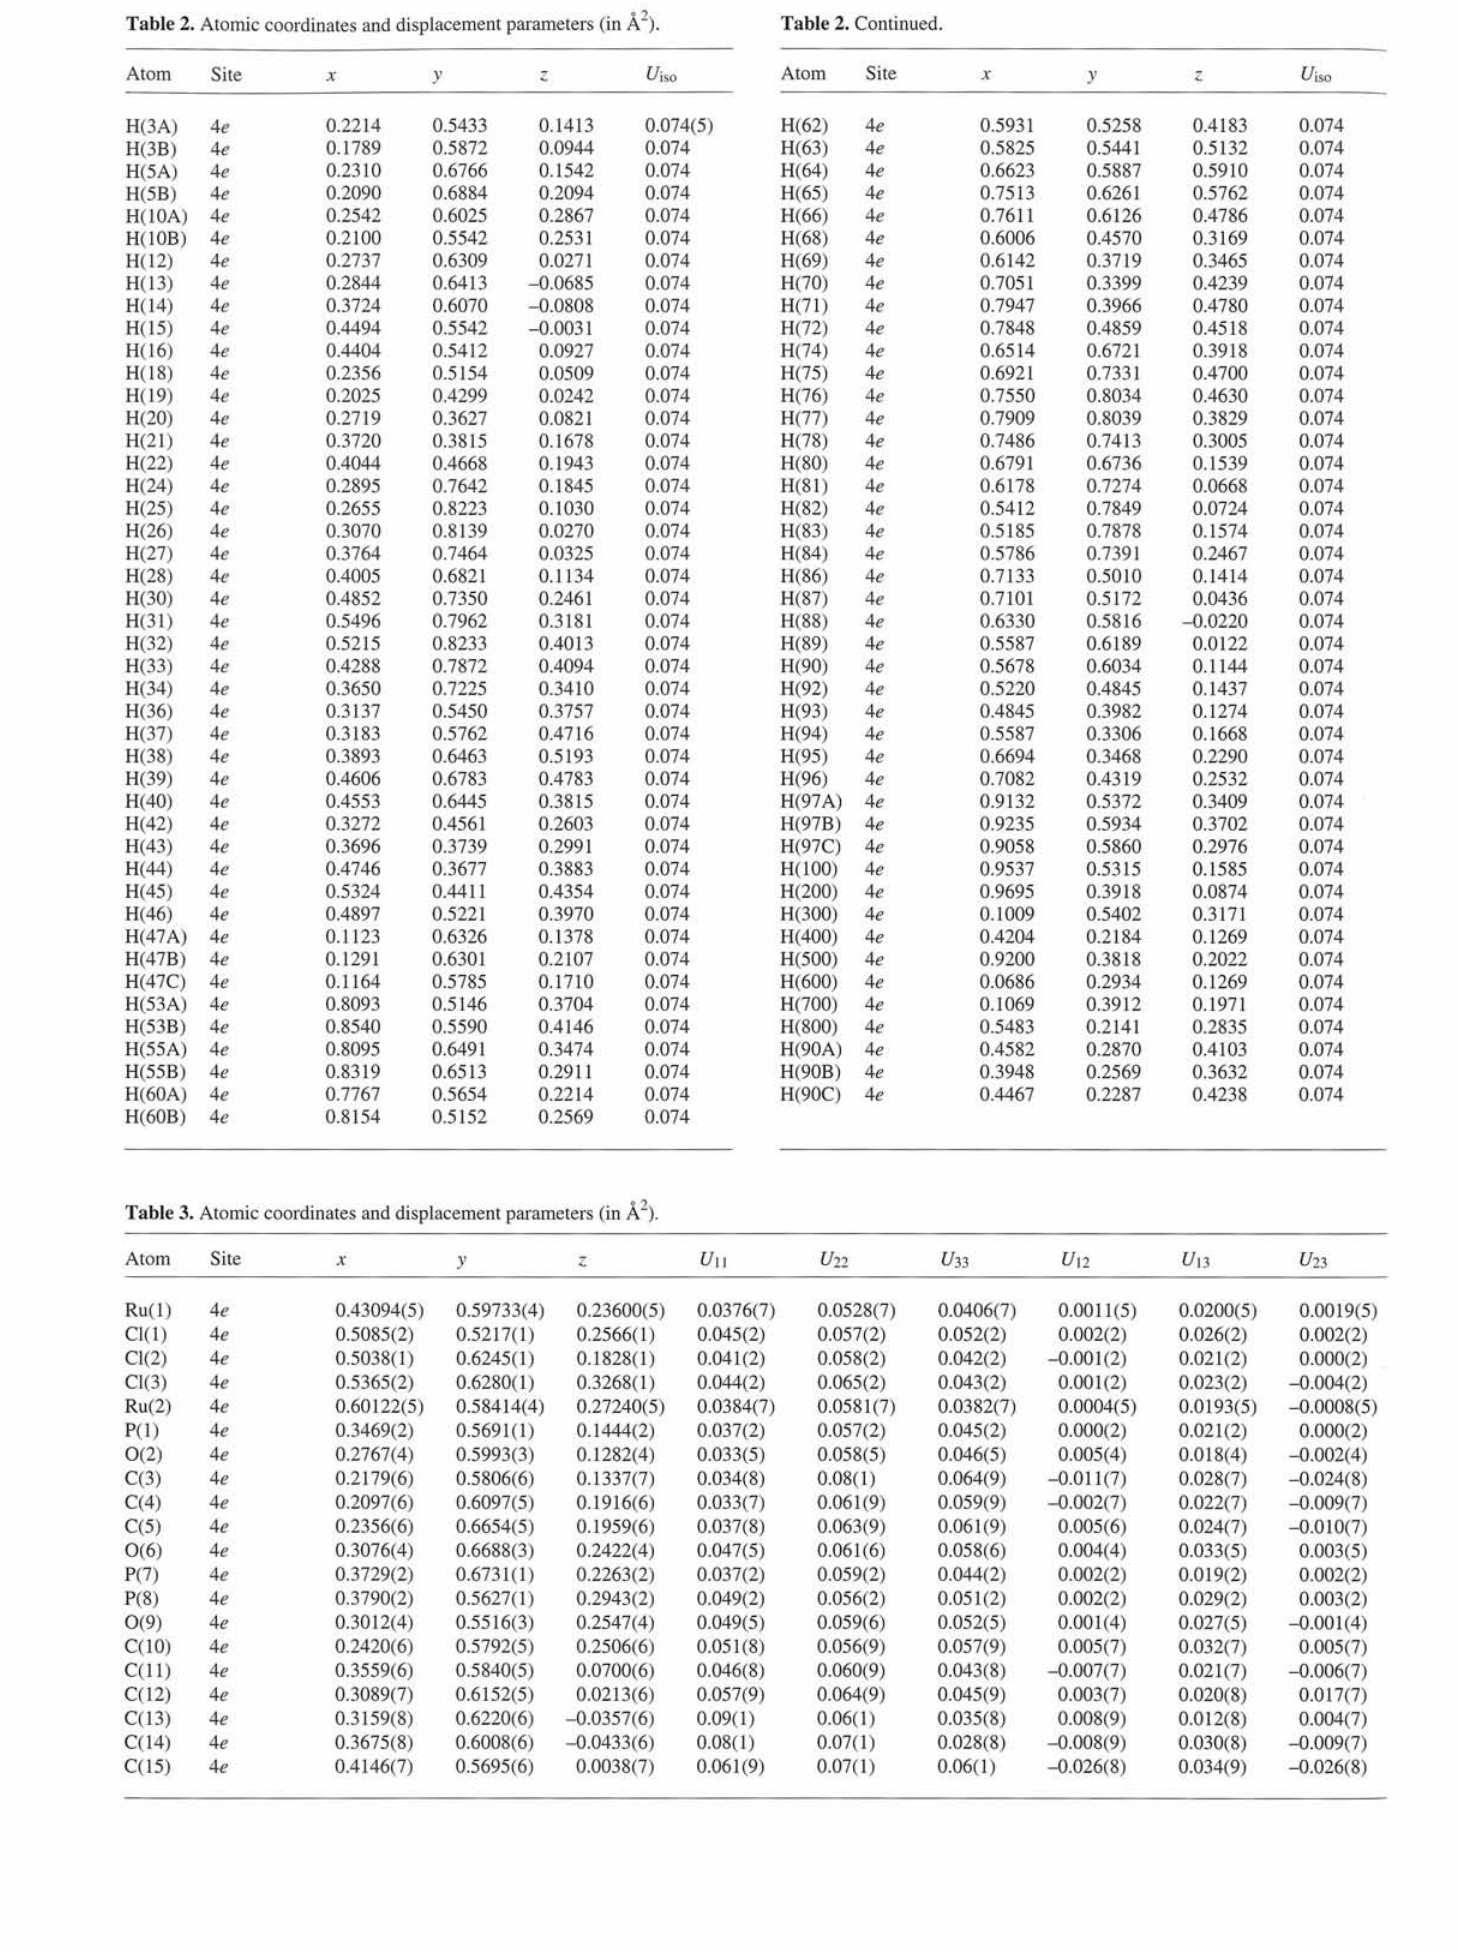
Table 2. Atomic coordinates and displacement parameters (in Â 2 ). Table 2. Continued.